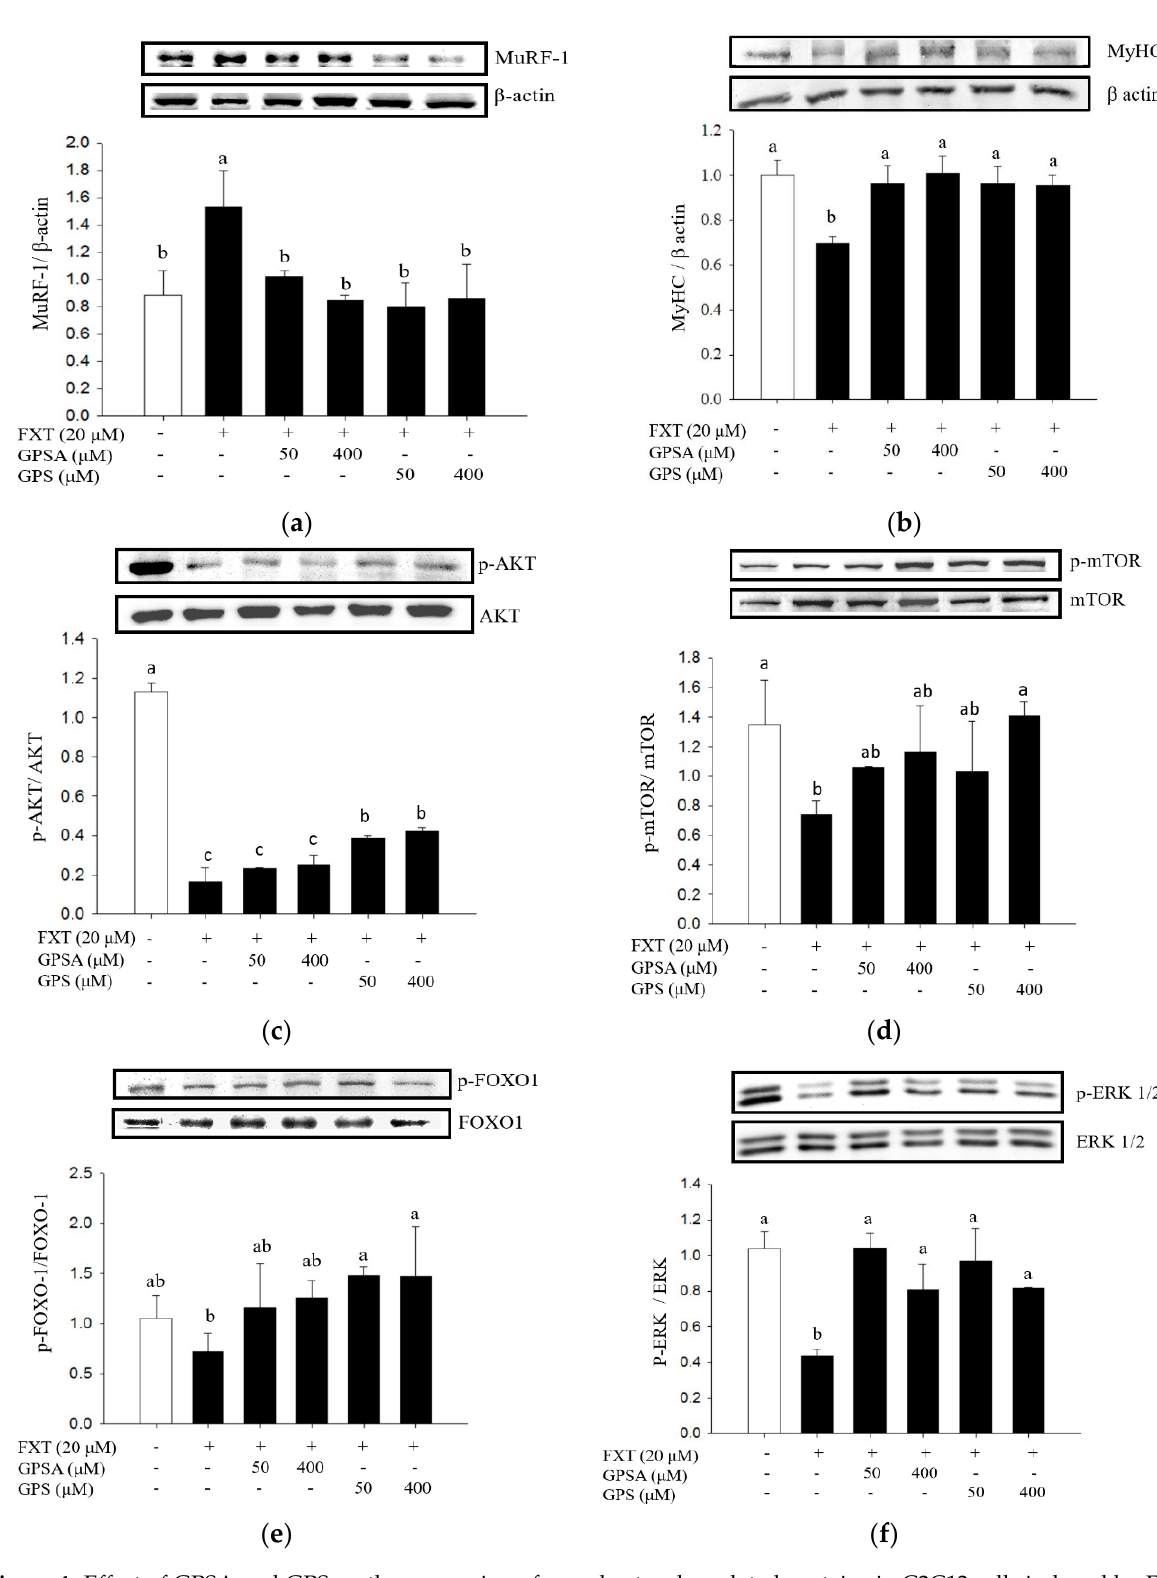
Figure 4. Effect of GPSA and GPS on the expression of muscle atrophy-related proteins in C2C12 cells induced by FXT. ( a ) MuRF-1, ( b ) MyHC, ( c ) AKT, ( d ) mTOR, ( e ) FOXO-1, and ( f ) ERK. C2C12 muscle cells were induced with FXT (20 μ M) and co-treated with GPSA or GPS at a dose of 50 M and 400 M, respectively, for 48 h. Data are expressed as mean ± SD ( n = 3). Different letters in lowercase indicate significance between one another as p < 0.05.